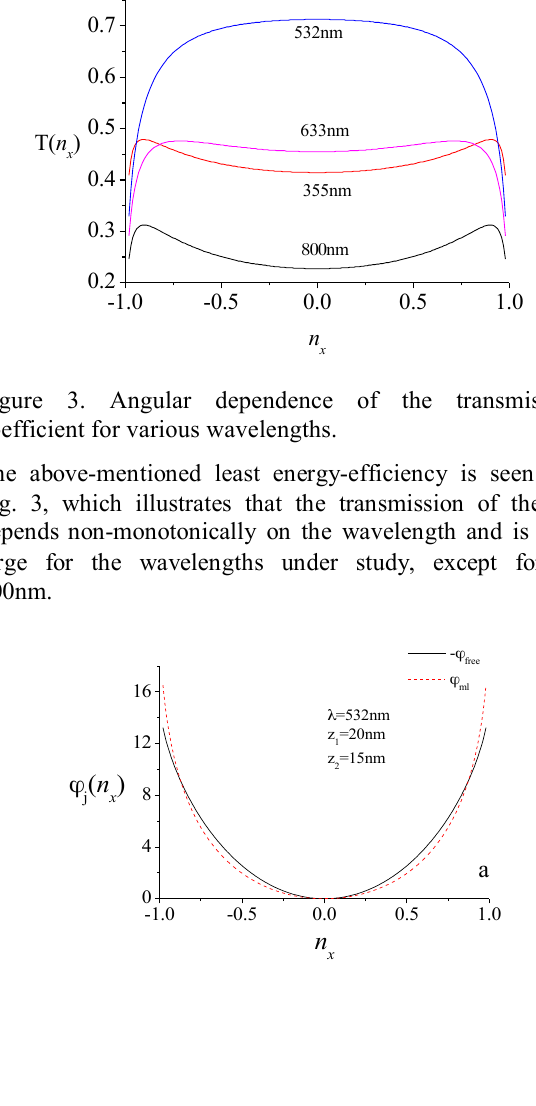
Figure 2. Phase functions of multilayer at wavelength λ = 355 nm(a); 532 nm(b); 633 nm(c); 800 nm(d); Hereinafter the phase is measured in degrees.